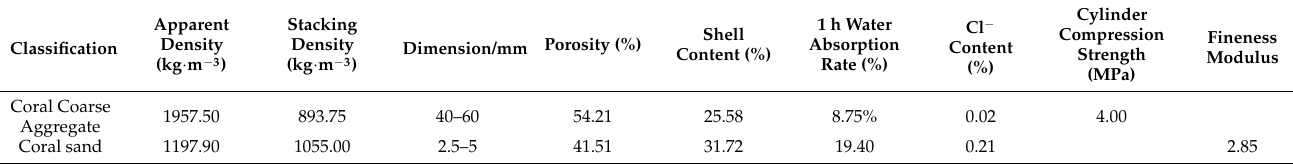
Figure 2. Polypropylene fiber.